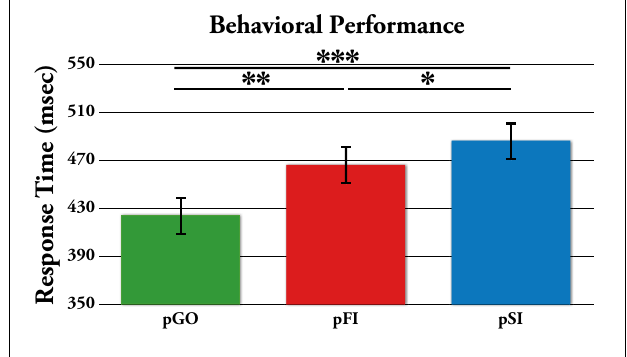
FIGURE 2 | Mean response time (RT) for each trial type, with the standard error of the mean represented as error bars. pGO: GO trial following a GO trial. pSI: GO trial following a successful inhibition trial. pFI: GO trial following a failed inhibition trial. ∗ p < 0 . 05, ∗∗ p < 0 . 001.